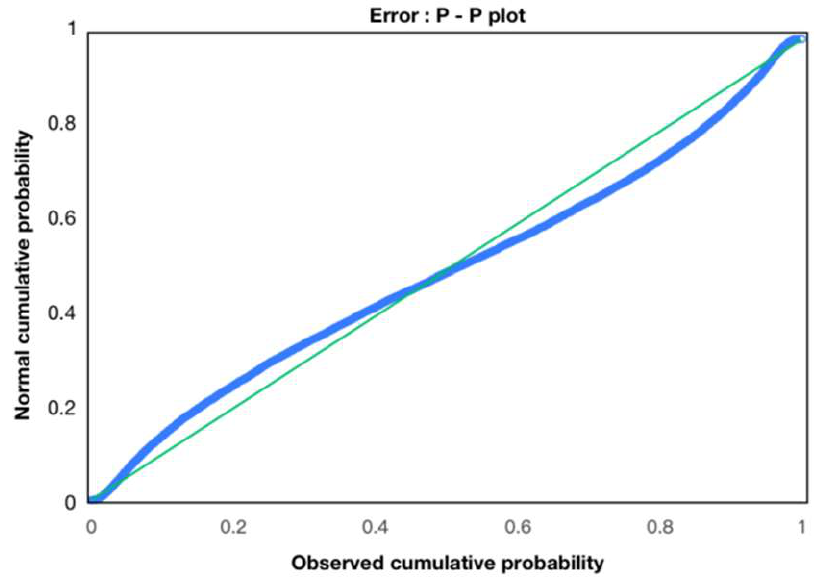
Figure 15. Histogram of normality test.